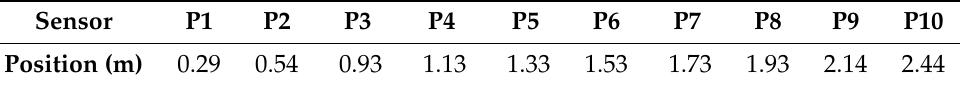
Figure 5. Sketch of the model displaying the rockfill shell, along with the base and core, with two regions for ( a ) internal and ( b ) external toe configuration. The coordinate system, drawn in blue, is placed at the origin. The locations of the installed pressure sensors are listed as P1–P10 (see Table 1). Table 1. Sensor position along the dam body, represented as the x -axis in Figure 5.